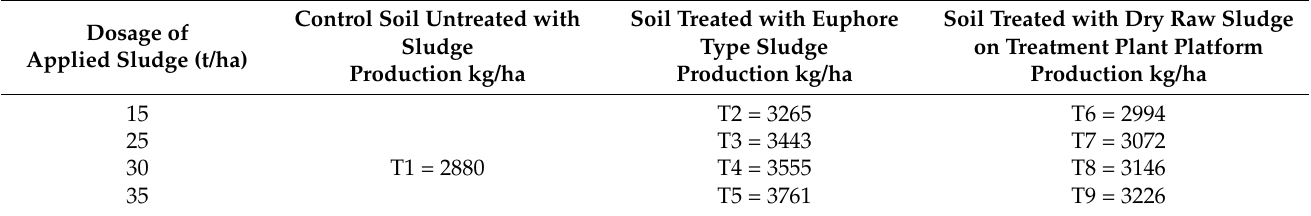
Table 2. Soybean average crop production in the nine experimental variants.